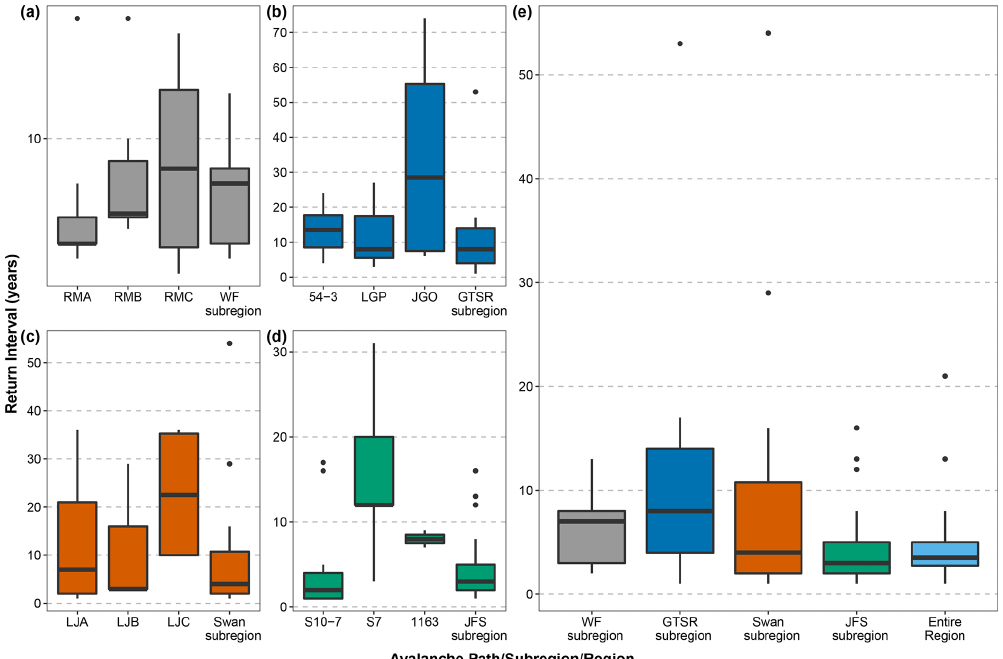
Figure 6. Boxplot of return intervals for individual avalanche paths in each subregion: (a) WF, (b) GTSR, (c) Swan, and (d) JFS. Panel (e) shows the boxplots of return intervals for the subregions and the overall region.